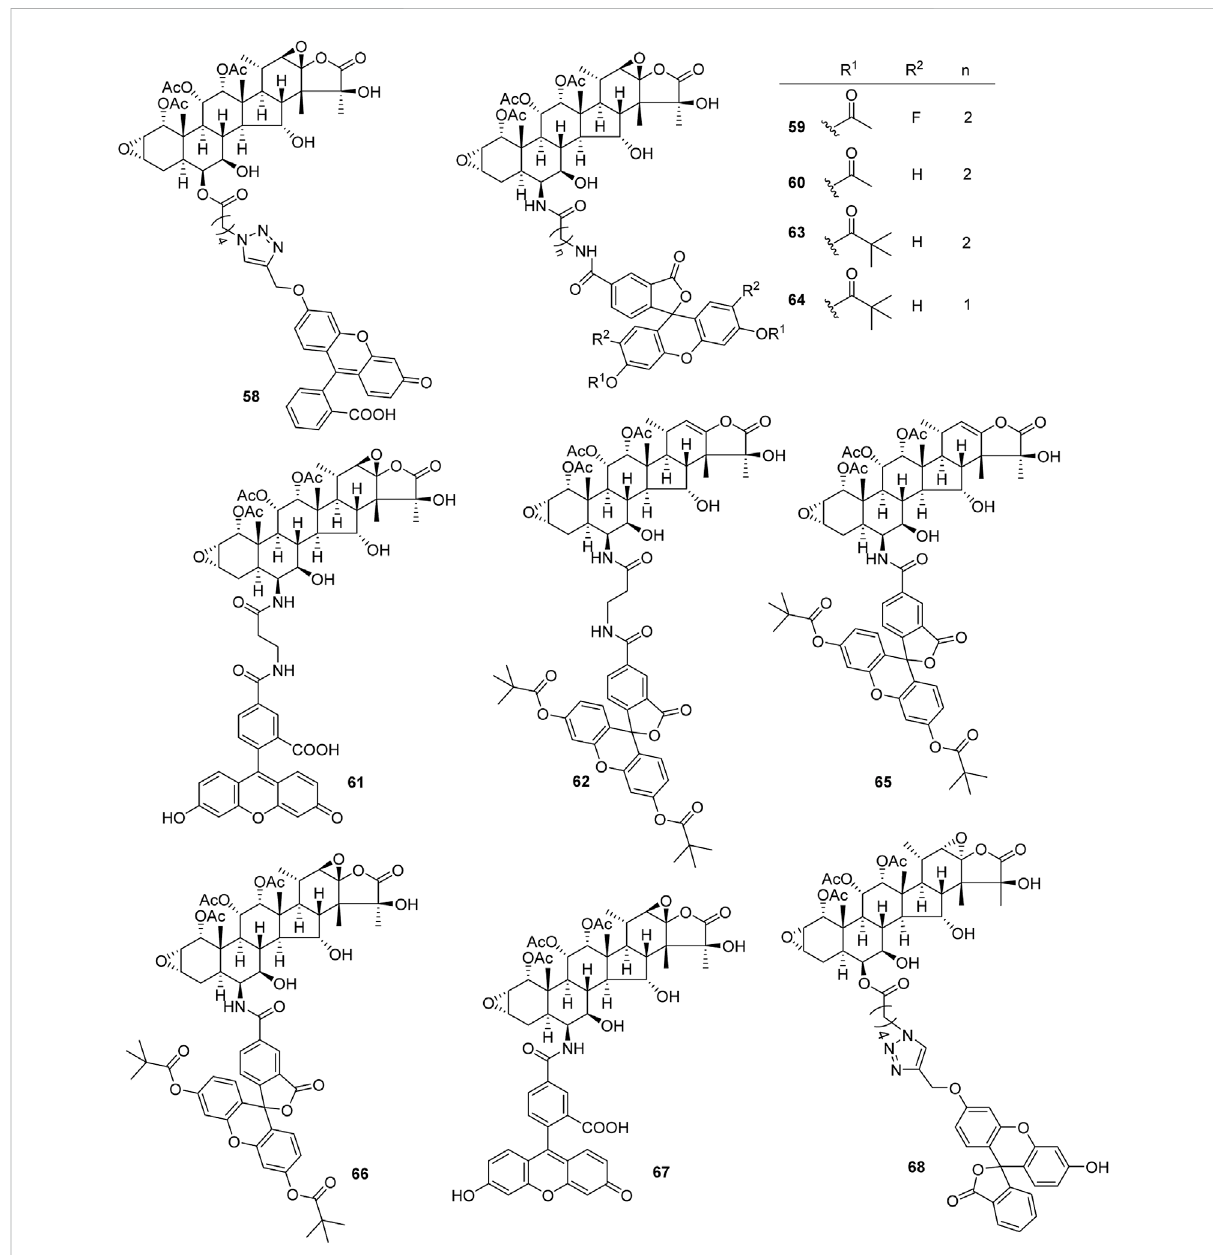
FIGURE 6 Structures of synthetic taccalonolides